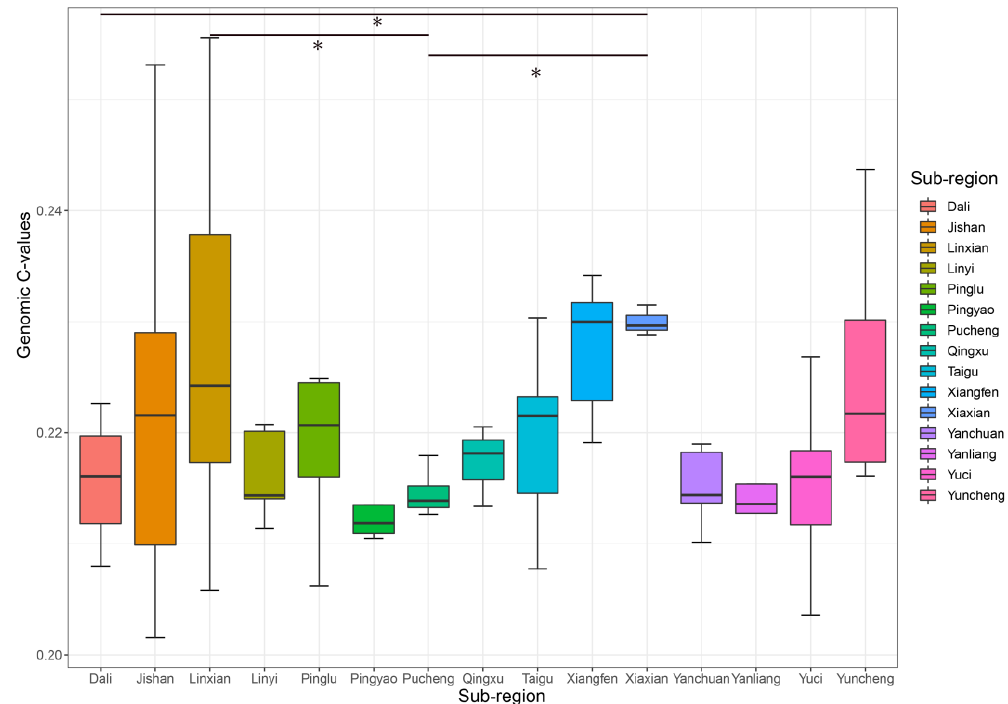
Figure 5. Degree of variation in genomic C-values of jujube germplasm in different sub-regions. Three or more germplasm were selected for analysis. * represents a difference between the two sub-regions at the 0.05